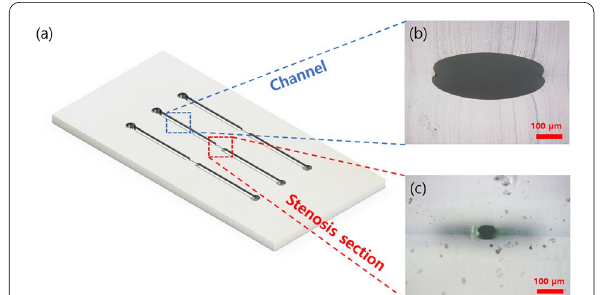
Fig. 1 3D model and cross‑section of channel with a stenosis percentage of 83.73% ( a ) 3D model of thrombus chip, ( b ) cross‑section of the channel, and ( c ) cross‑section of stenosis